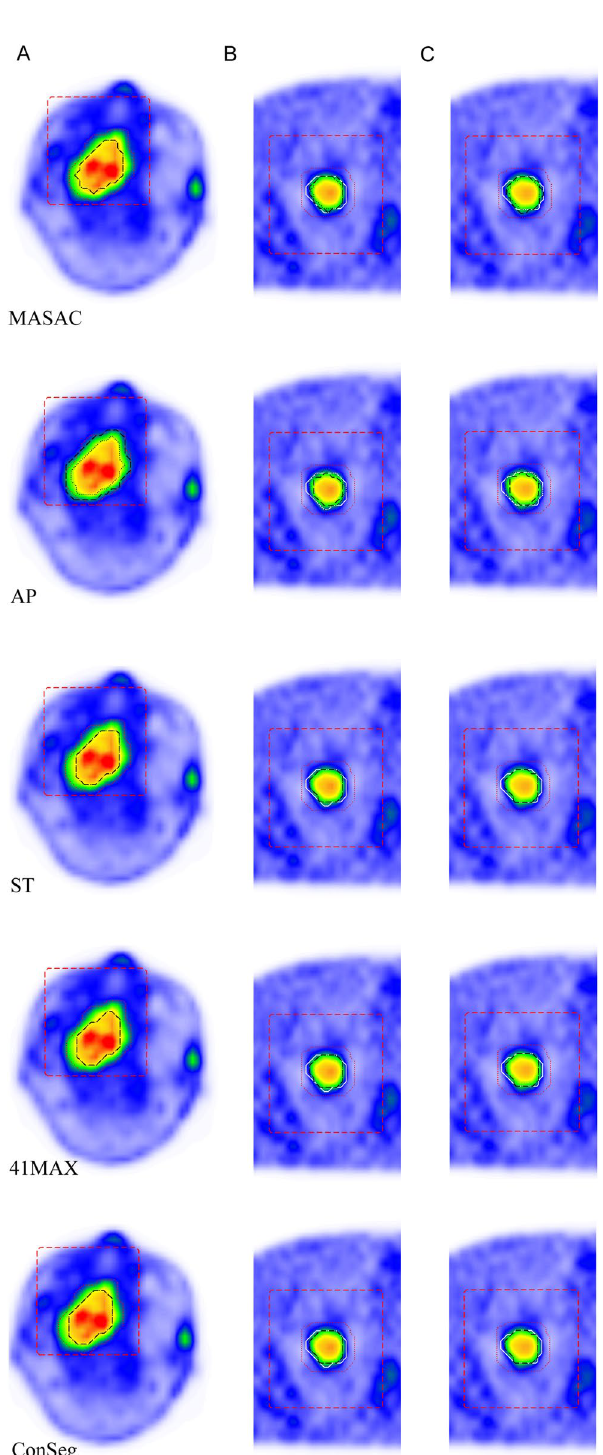
Fig. 2 Representative contours of five different methods (black dashed horizontal line: contours with the rectangle mask, black dotted line: contours with the irregular cropping mask, white: simulated ground truth ) with two initial masks (red dashed horizontal line: rectangle mask, red dotted line: irregular cropping mask) in clinical database ( A ) , anthropomorphic simulation with B and without C respiratory